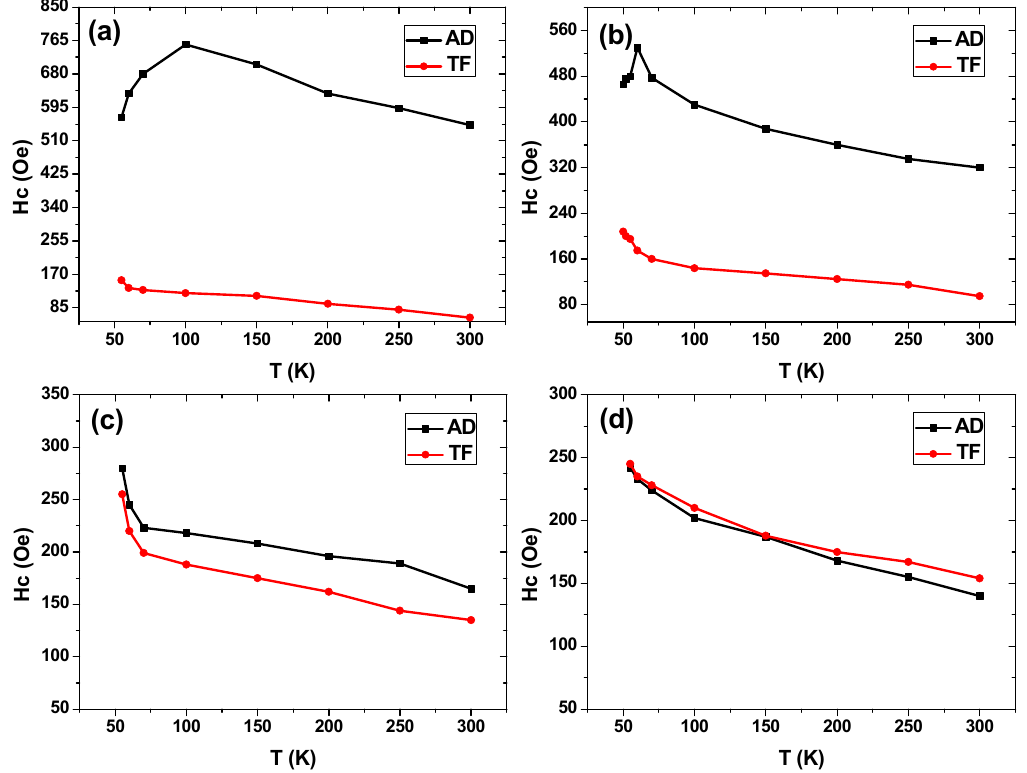
Figure 5. Temperature dependence of the in-plane coercivity for both nanopatterned and continuous Fe 70 Pd 30 thin films with different layer thicknesses: ( a ) 20 nm, ( b ) 40 nm, ( c ) 60 nm and ( d ) 80 nm.